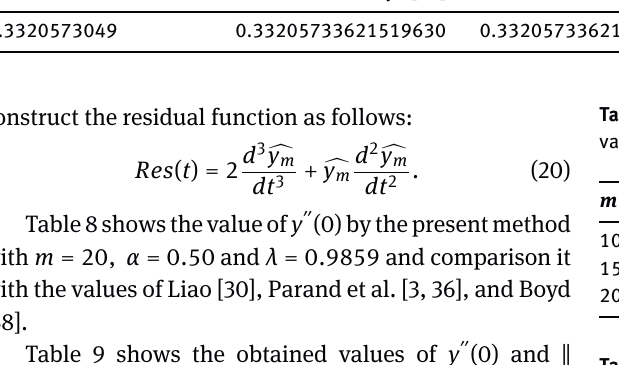
Table 8: Comparison of the obtained values of y ′′ (0) between the present method, Boyd [38], Parand et al. [3, 36], and Liao [30] Present